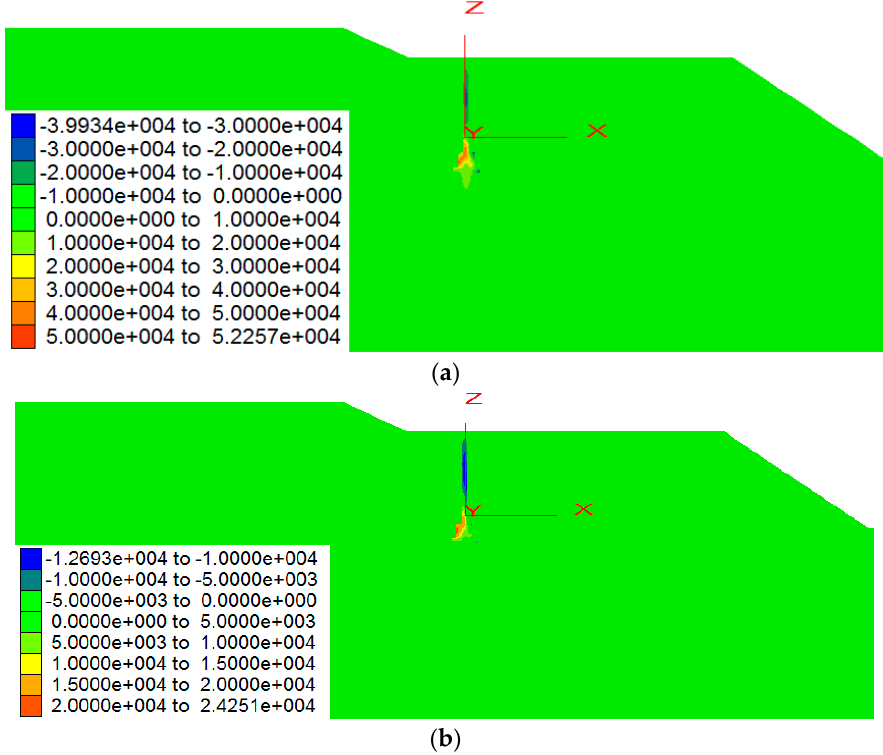
Figure 18. Comparison of XZ monitoring in-plane shear stress. ( a ) 1. ( b ) 2.